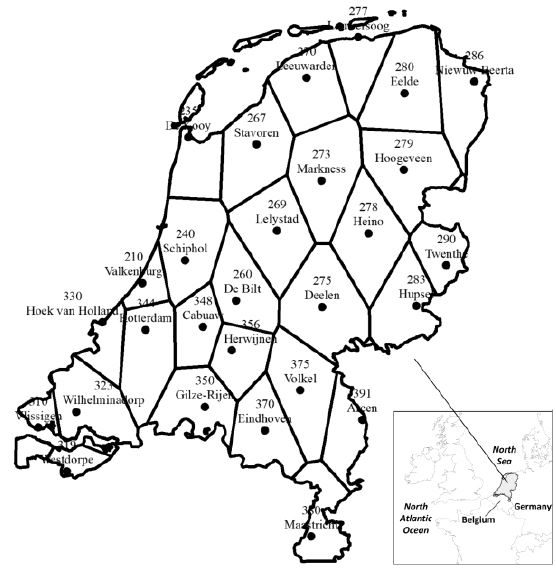
Figure 2. The Thiessen polygons map of Dutch weather